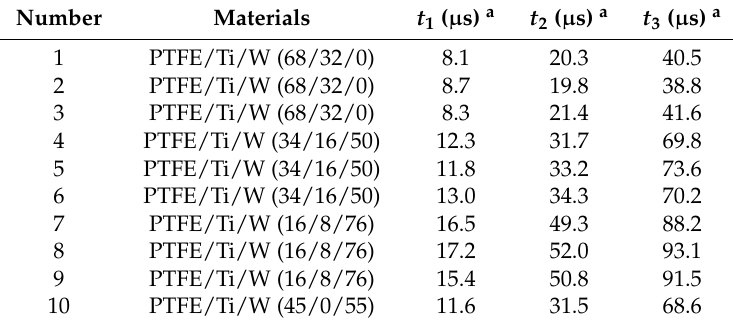
Table 2. Test results.